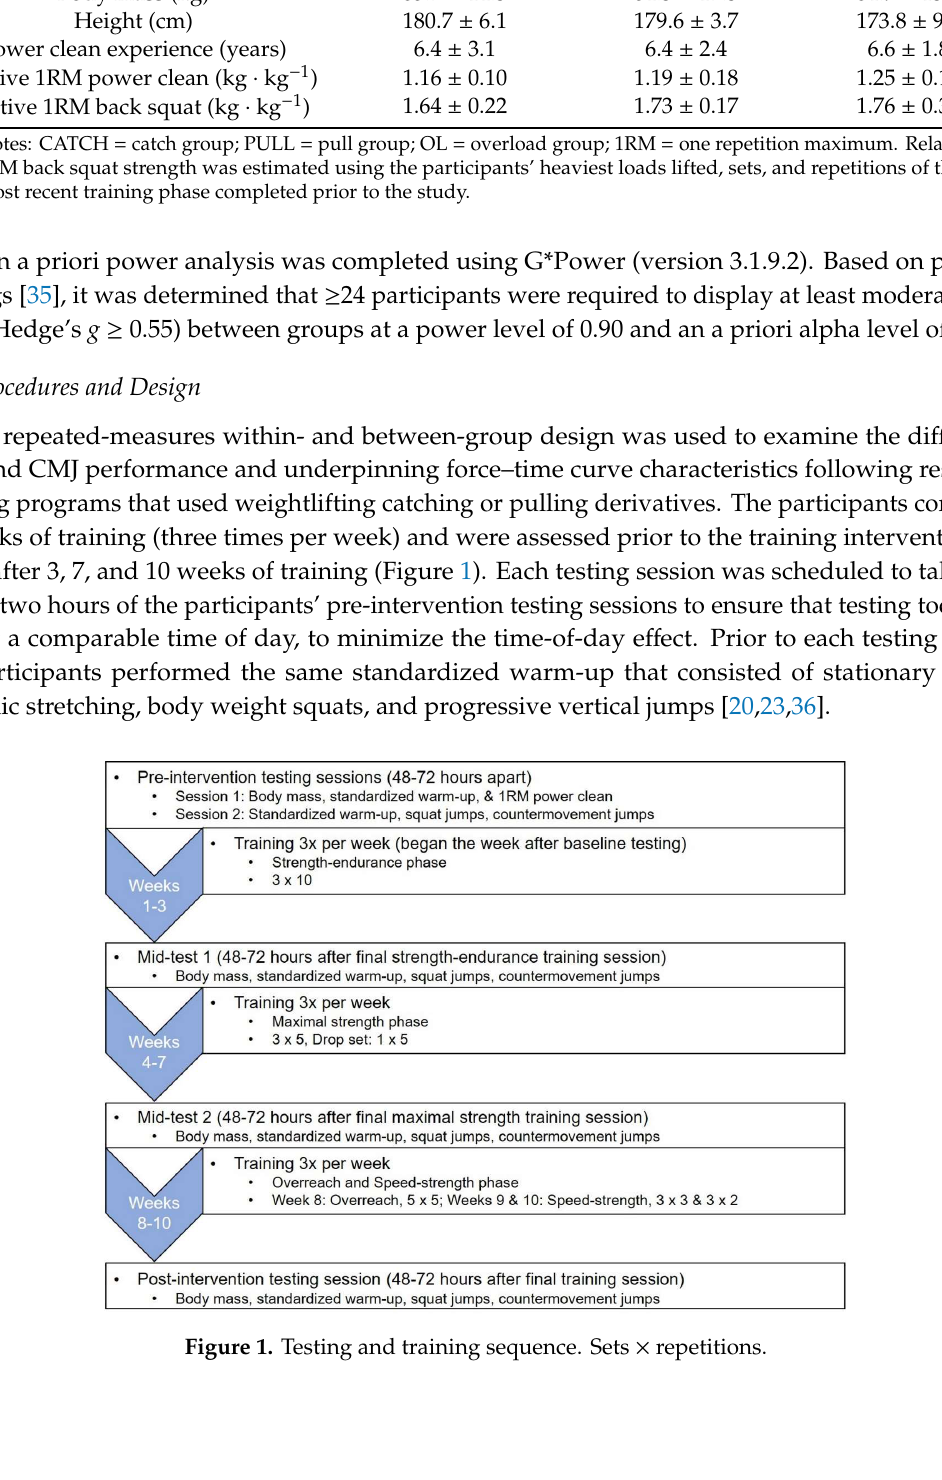
Table 1. Participant demographics for each training group.